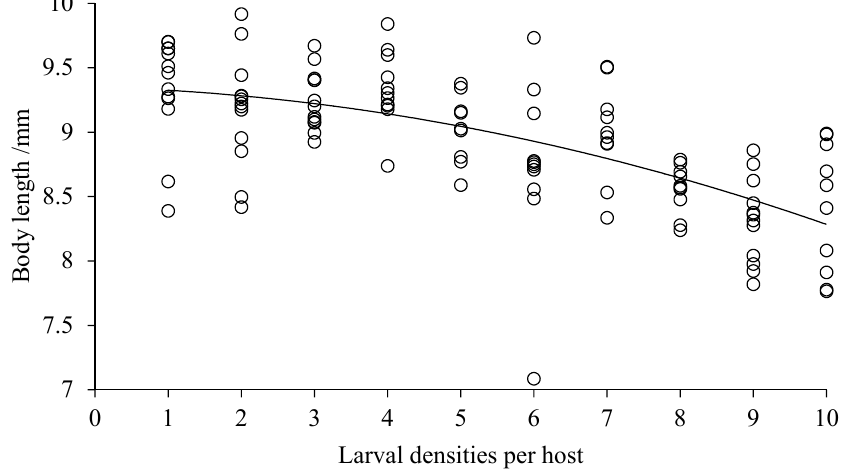
Figure 2. Body length of D. helophoroides adults emerging per host with various larval densities. Relationship between larval densities per host and body length width of D. helophoroides adults ( y = − 0.0091 x 2 − 0.0153 x + 9.3497; adjusted r ² = 0.8655, p = 0.0001).